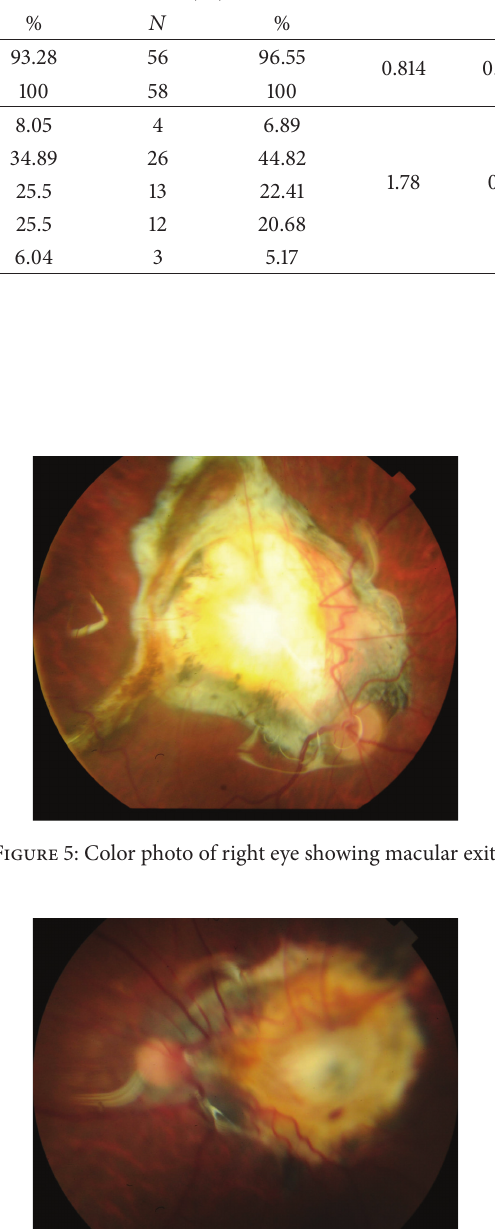
Table 4: Postoperative anatomical and functional results in both groups.